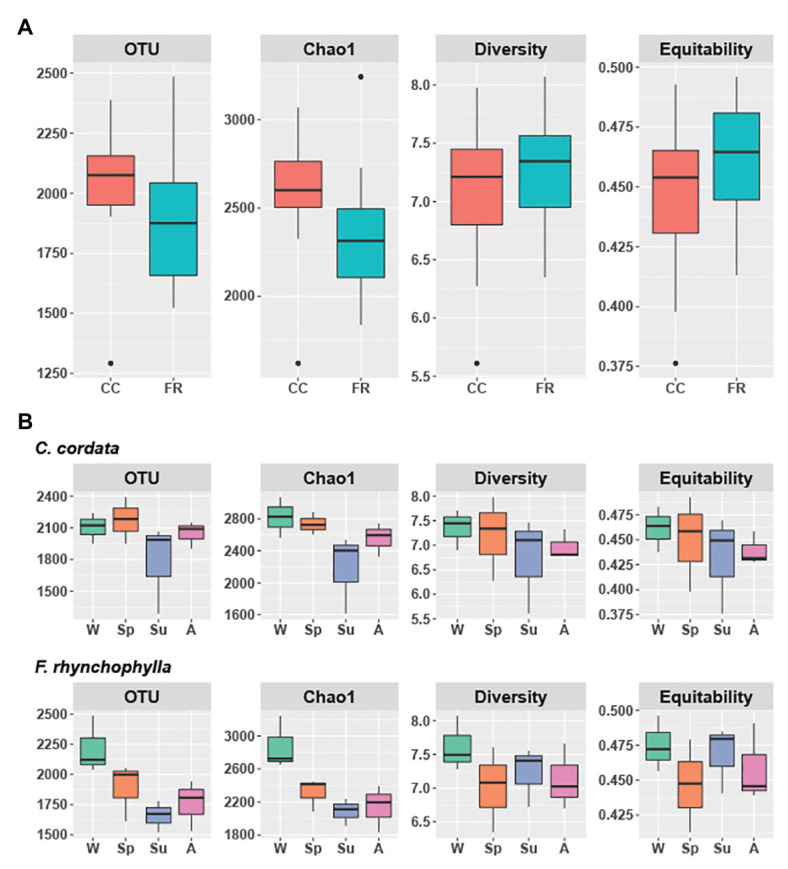
Alpha diversity of soil fungal communities from Carpinus cordata and Fraxinus rhynchophylla forests. (A) Overall alpha diversity of the rhizospheric soil under the dominant tree species in each forest and (B) Seasonal variation in alpha diversity in C. cordata and F. rhynchophylla: W (winter), Sp (spring), Su (summer), and A (autumn). Richness is represented by the number of OTUs and Chao1. Diversity and equitability were estimated with Shannon’s index. Significant differences in alpha diversity indices were tested using Kruskall-Wallis test with LSD Fisher post hoc test adjusted by the Bonferroni method. The box indicates the first and third quartiles, and black line in the middle indicates the median value.